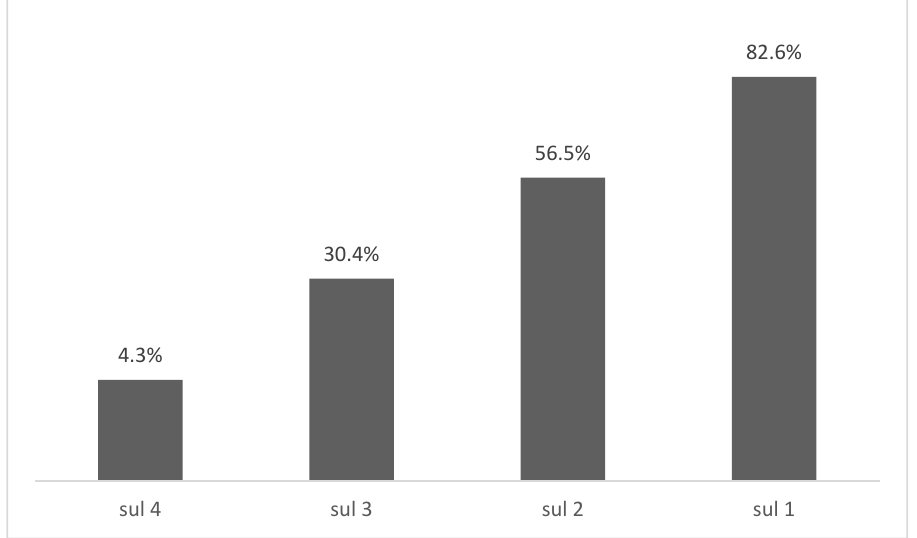
Figure 2. Percentage of studies that searched for sulfonamide resistance genes.